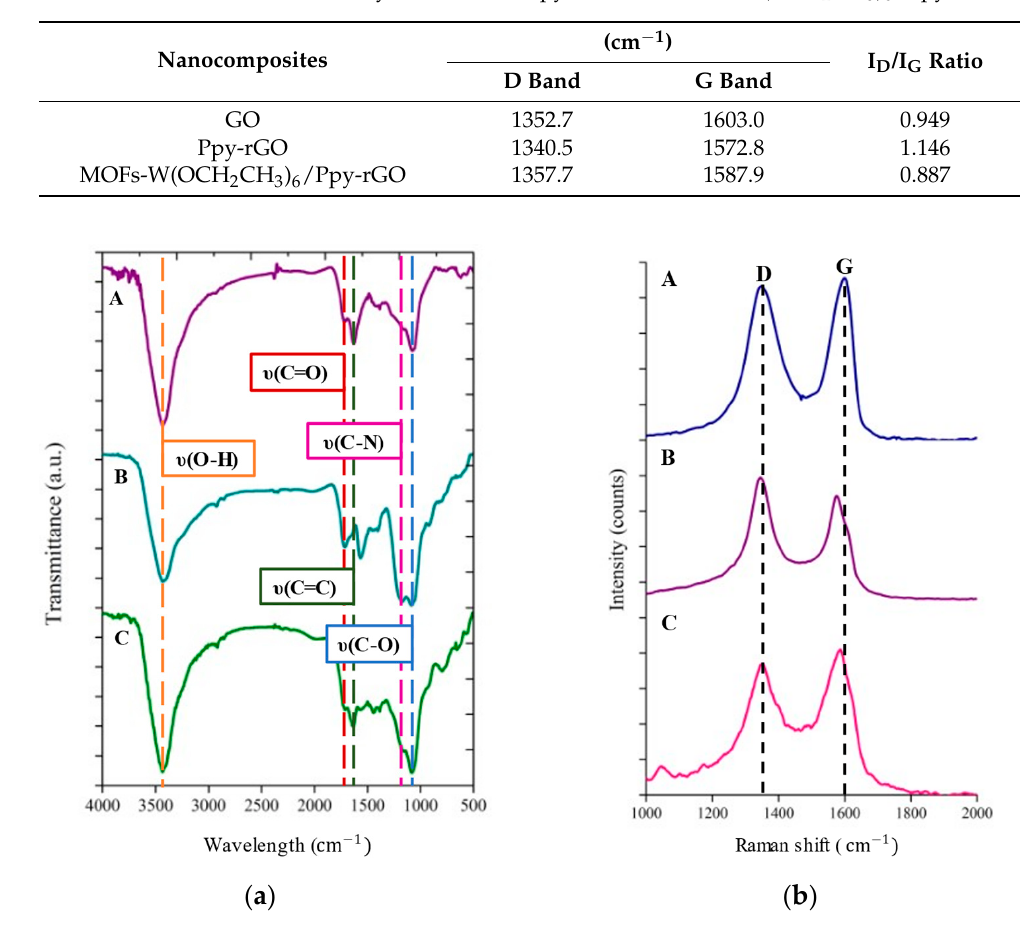
Figure 2. ( a ) FTIR spectra and ( b ) Raman spectra of (A) GO, (B) Ppy-rGO prepared in deionized water, and (C) MOFs-W(OCH 2 CH 3 ) 6 /Ppy-rGO prepared in DMF. water, and (C) MOFs-W(OCH 2 CH 3 ) 6 /Ppy-rGO prepared in